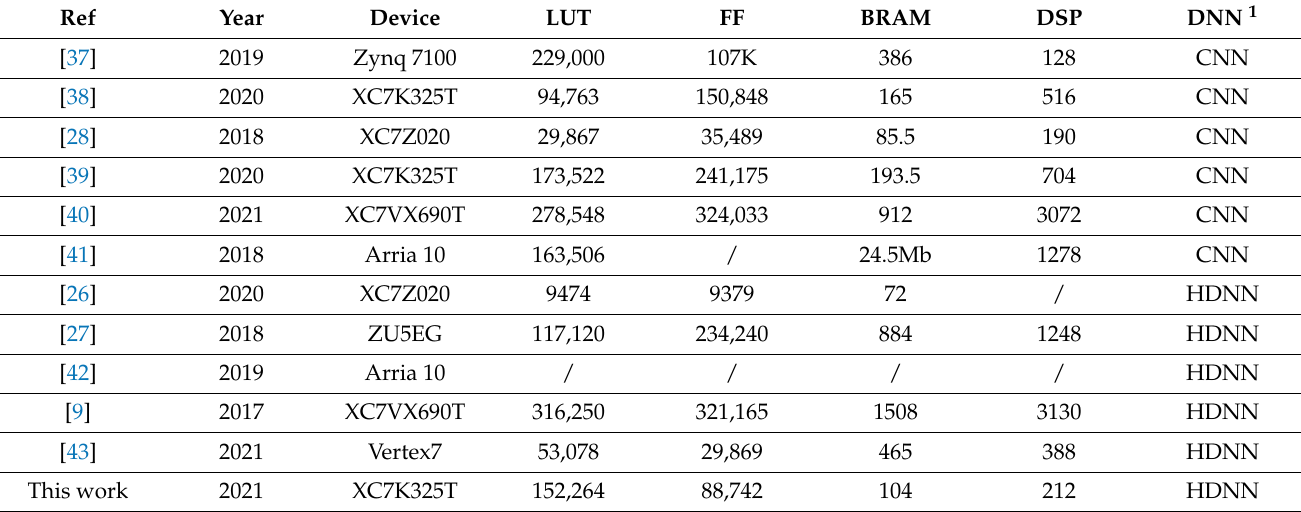
Table 1. The FPGA resource utilization of this work and the comparison with the previous works.